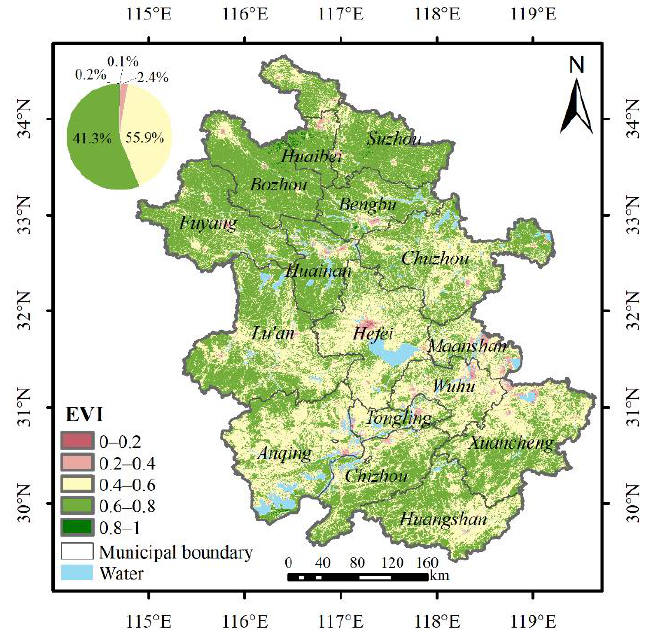
Figure 4. Spatial distribution of average EVI in Anhui Province during 2000 – 2020. Table 3. Area transfer matrix of EVI in Anhui Province during 2000–2020 (km 2 ).